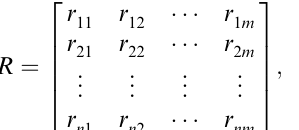
Fig. 2. General process of a single-level fuzzy compre- hensive